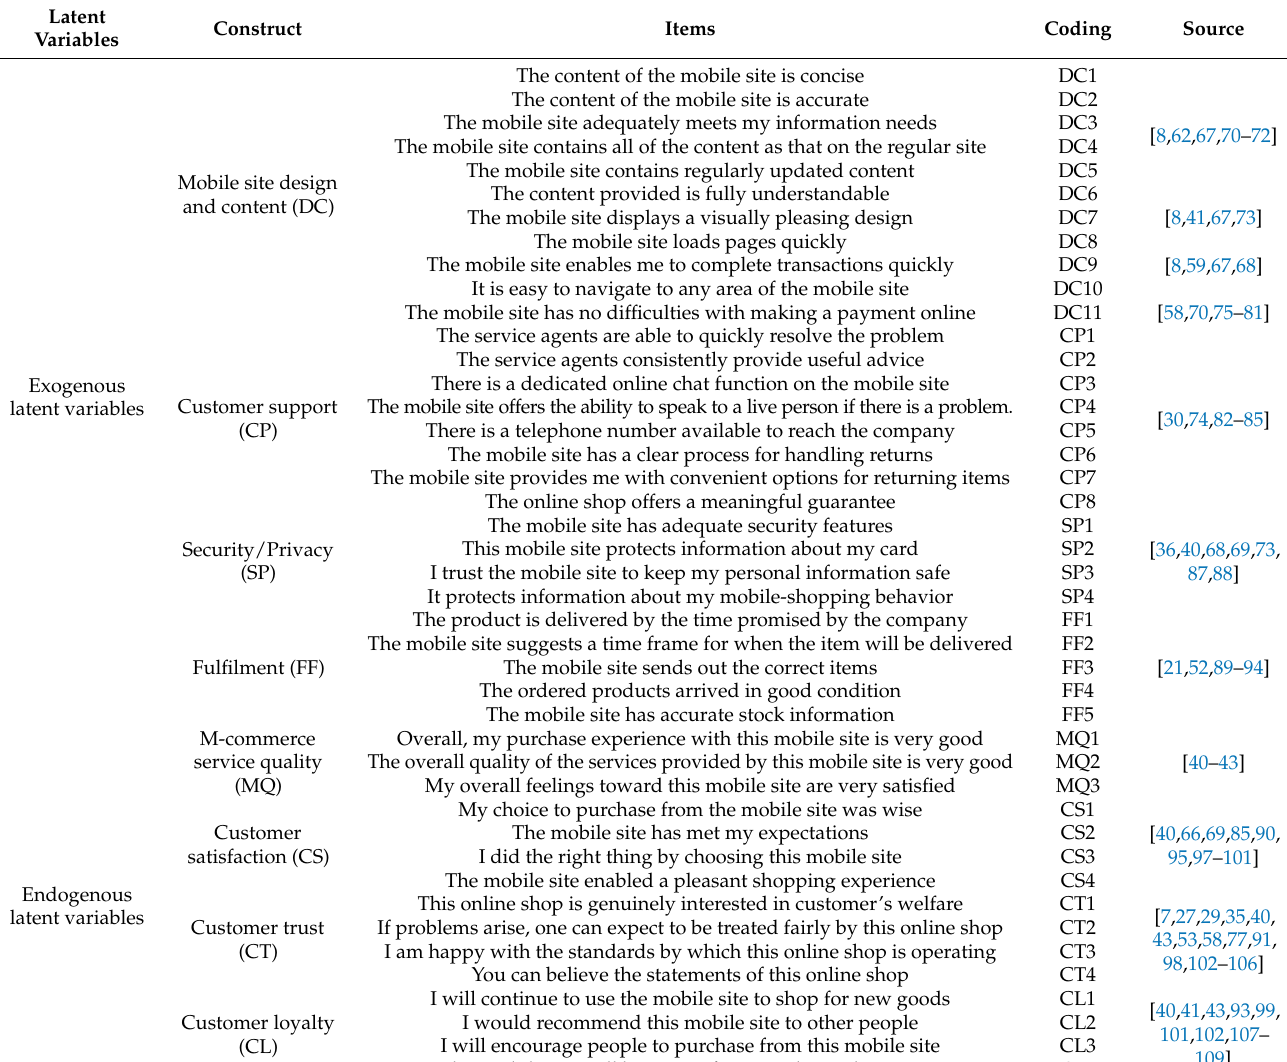
Table 1. Constructs, items, and coding for structural